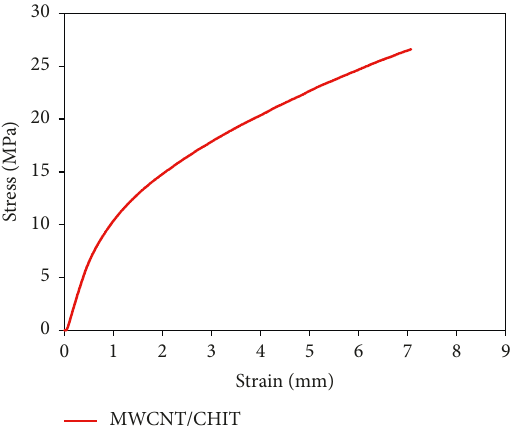
Figure 4: The stress vs. strain of MWCNT/CHIT evaporative cast membrane. Table 1: Values found for the EC membrane comparing with other techniques used for the membrane.